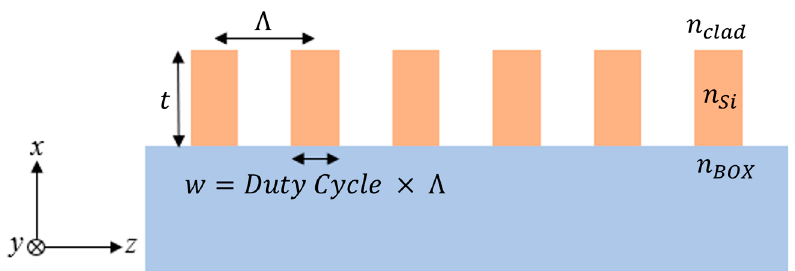
Figure 2. Sideview diagram of z -periodic subwavelength grating on